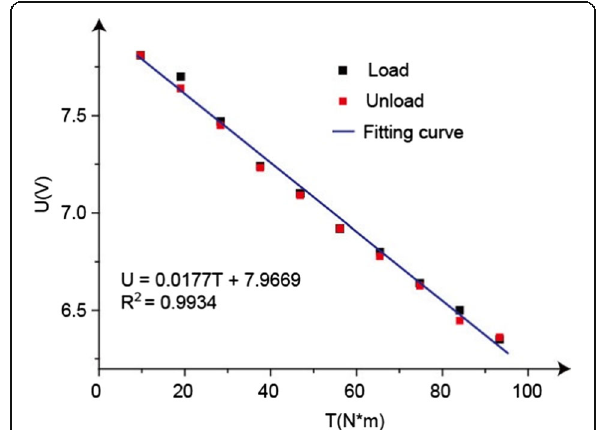
Fig. 3 The output of the torque sensor